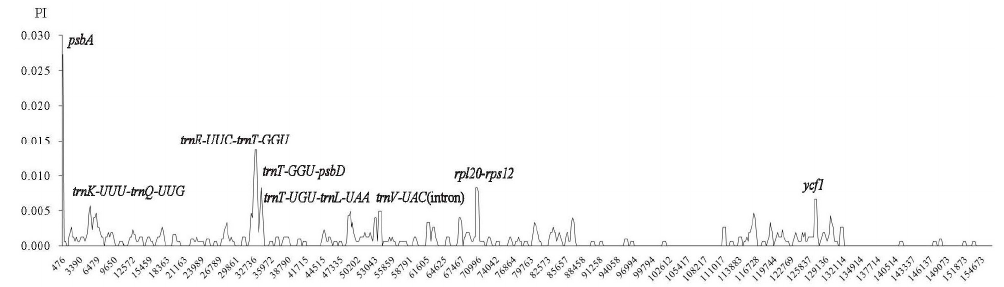
Figure 6. Sliding-window analysis on the cp genomes for five Aconitum species. X-axis: position of the midpoint of a window; Y-axis: nucleotide diversity (Pi) of each window.